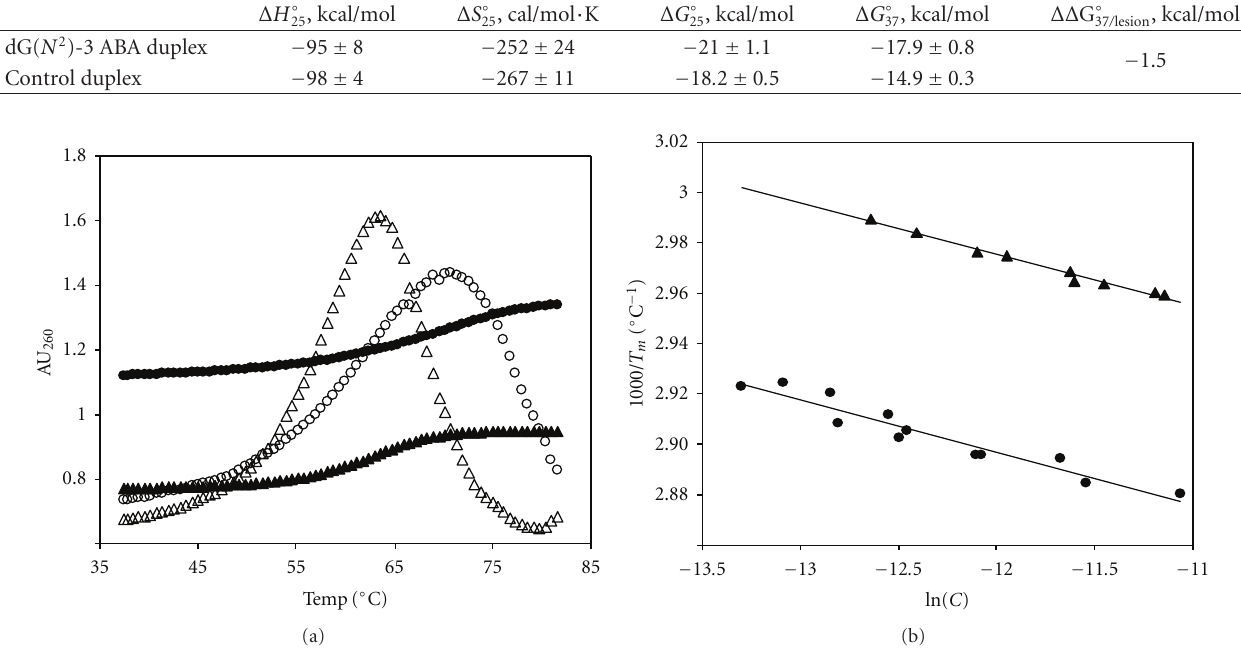
Figure 4: Typical melting curves of the dG( N 2 )-3ABA-containing (circles) and unmodified (triangles) 14-mer duplexes, with open symbols showing their first derivative curves (a). (1/ T m ) versus ln[ C ] plots for the same oligonucleotides